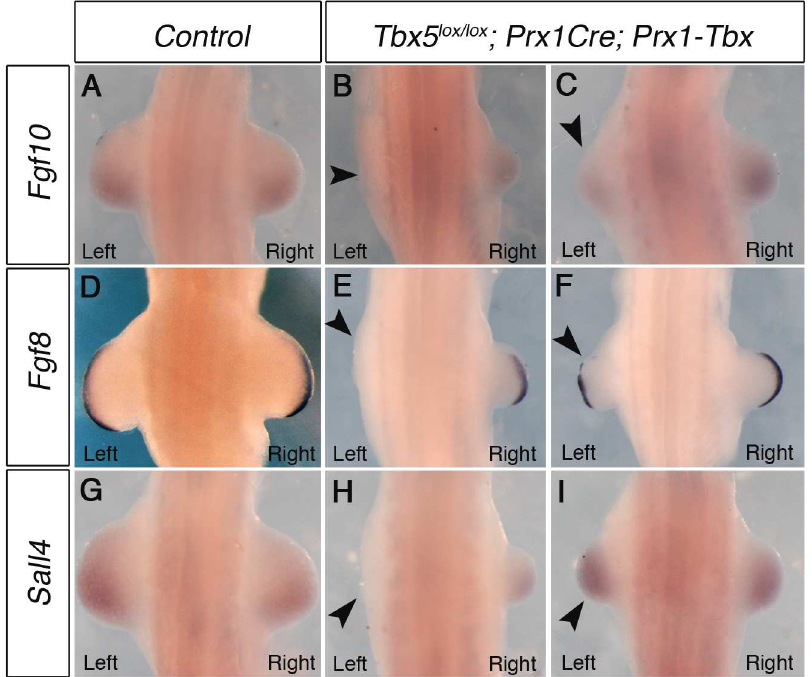
Fig 2. Markergene expression in left and right forelimb buds of Tbx hypomorphs. WISH analysisof E10.5 embryos. A, Fgf10 expressionin a control embryo B, Left forelimb bud is not formed and Fgf10 expressionis lost on the left side (arrowhead)in a severely affected embryo C , Fgf10 is weaker in left forelimb of a mildly affected embryo (arrowhead). D, Fgf8 expressionin control E , Fgf8 is absent in left AER of a severely affected embryo (arrowhead). F, Fgf8 is disrupted in left AER of a mildly affected embryo (arrowhead). G, Sall4 expressionin control. H , Sall4 is absent in left LPM of a severely affected embryo (arrowhead). I , Sall4 is expressedat similar levels bilaterallyin a mildly affected embryo. A minimum of 4 mutants for each phenotype were analysedwith each